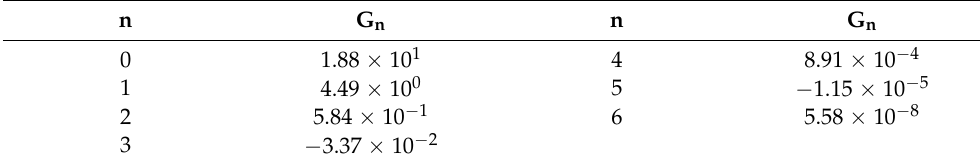
Table A55. Coefficients of the CH 3 OH-ZnBr 2 enthalpy